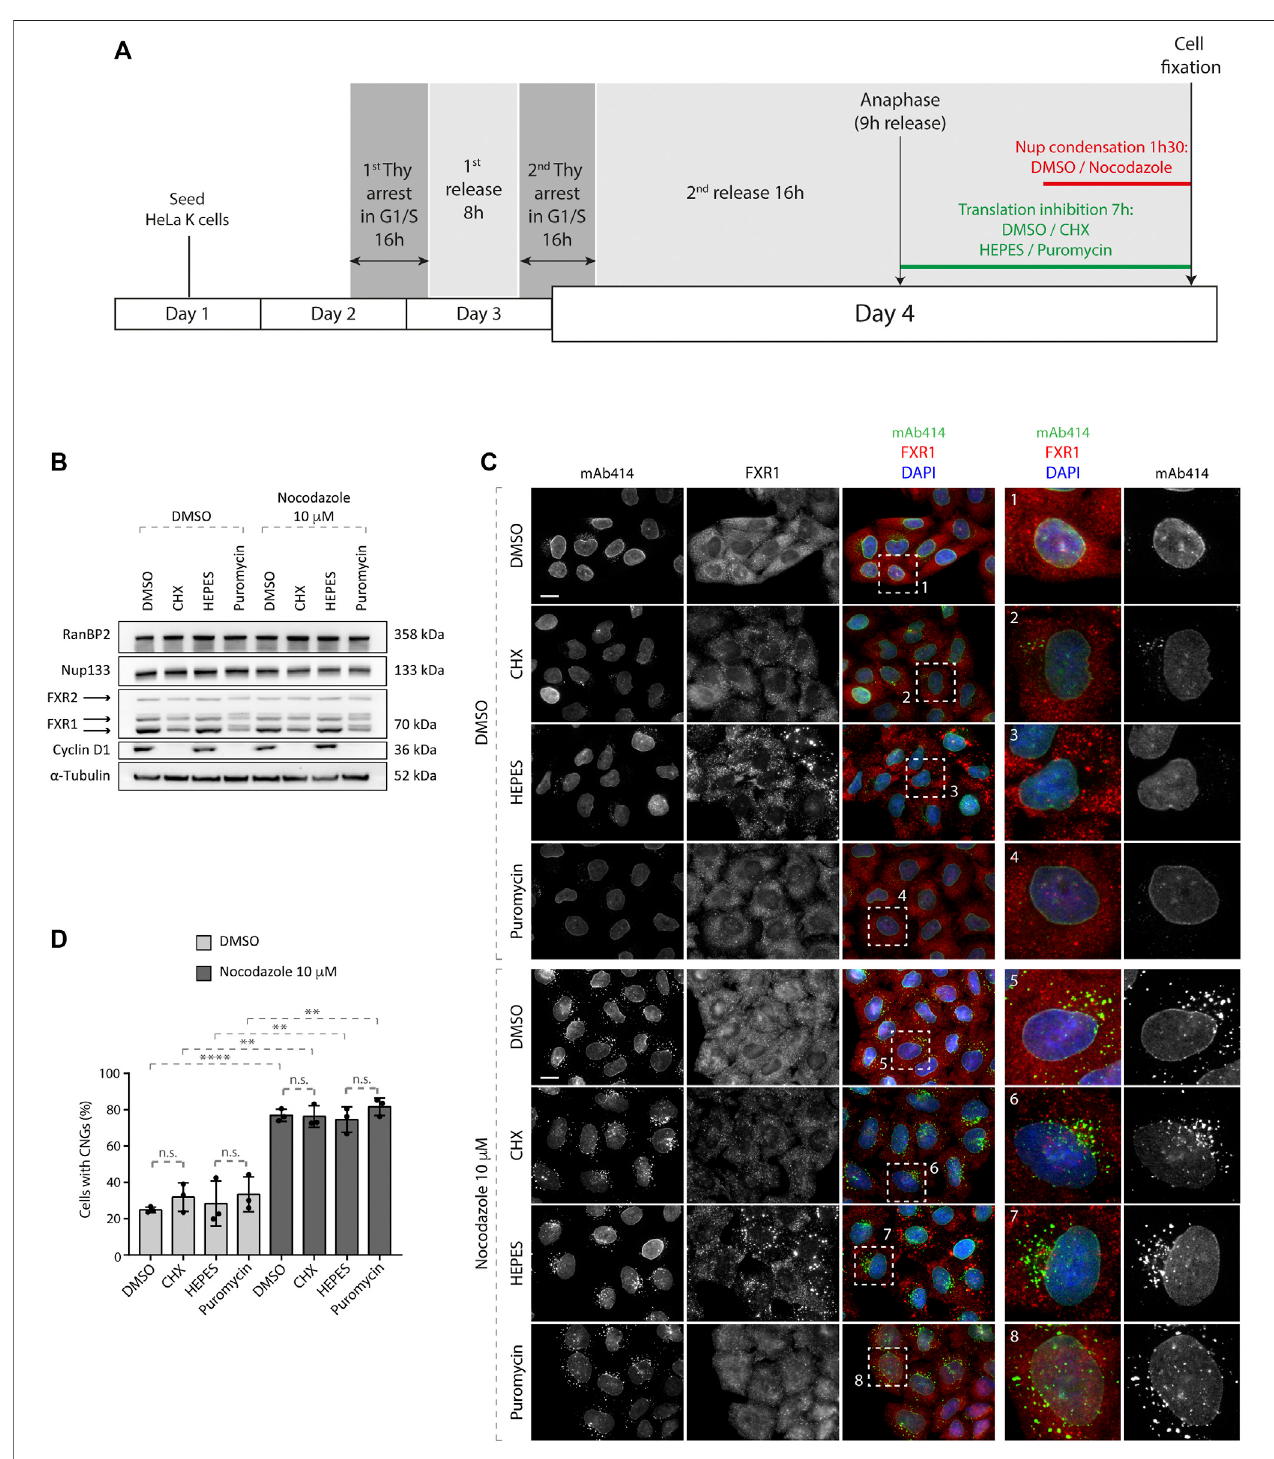
FIGURE1| Nupgranuleformationuponmicrotubuledepolymerizationdoesnotdependonactivetranslation. (A) Schemeoftheexperimentalsetup.HeLaKcellswere seededoncoverslips,synchronizedbydoublethymidineblock,andreleasedfromG1/Sarrest.Ninehoursafterrelease(whensynchronizedcellswereinanaphase),thecells were incubated with translational inhibitors (100 μ g/ml cycloheximide (CHX) or 200 μ g/ml puromycin) or the vehicles (DMSO and HEPES, respectively) for additional 7 h. During the last 90 min, Nup granules were induced by the addition of 10 µM nocodazole or the vehicle (DMSO) in the presence of the translational inhibitors. Subsequently,thecellswereanalyzedbyWesternblotting (B) andimmuno fl uorescencemicroscopy (C,D) . (B) Wholecelllysatesfromcellstreatedasin (A) wereanalyzedby Western blotting. (C, D) Cells treated as in (A) were analyzed by immuno fl uorescence microscopy (C) and the percentage of cells with cytoplasmic nucleoporin granules (CNGs) was quanti fi ed. (D) 5,900 cells were analyzed (mean ± SD, ** p < 0.01; **** p < 0.0001, n.s. (cid:1) non-signi fi cant, N (cid:1) 3). The magni fi ed framed regions are shown inthe corresponding numbered panels. Data information: scale bars are 5 μ m. Statistical signi fi cance was assessed by one-way ANOVA test with Sidak ’ s correction.